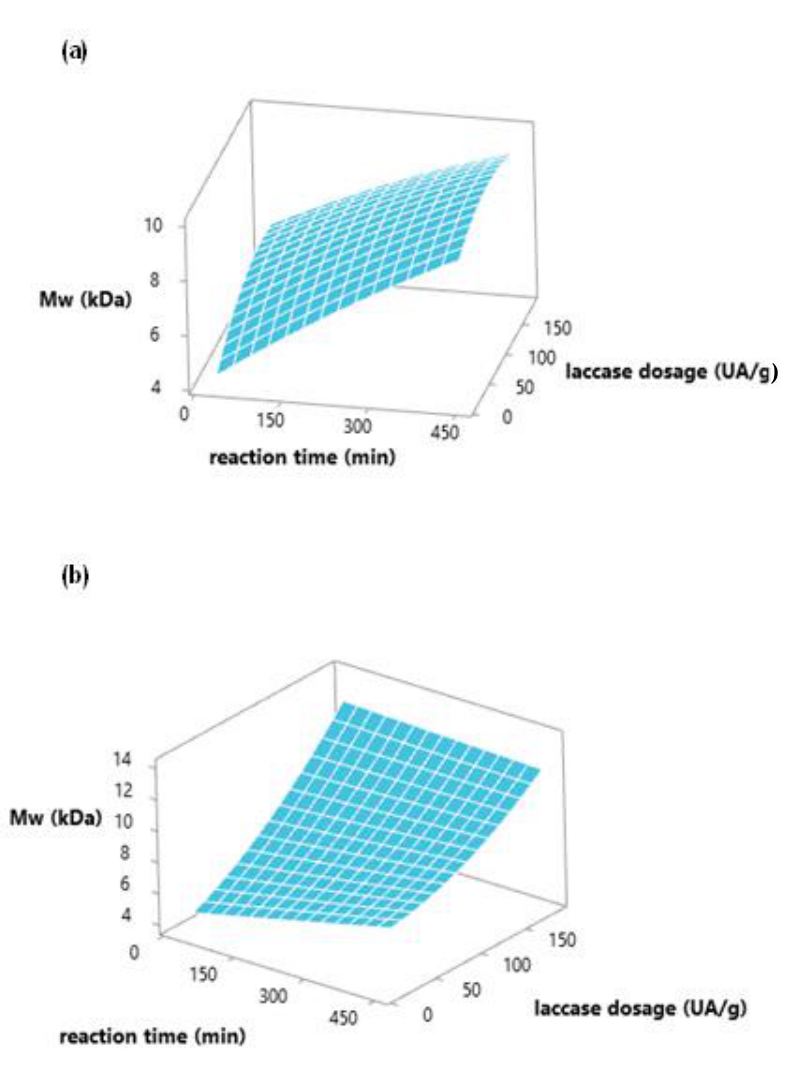
Figure 4. Response surface plot of weight-average (Mw) molecular weight values (KDa) to evaluate MtL ( a ) and SiLA ( b ) laccases dosage and reaction